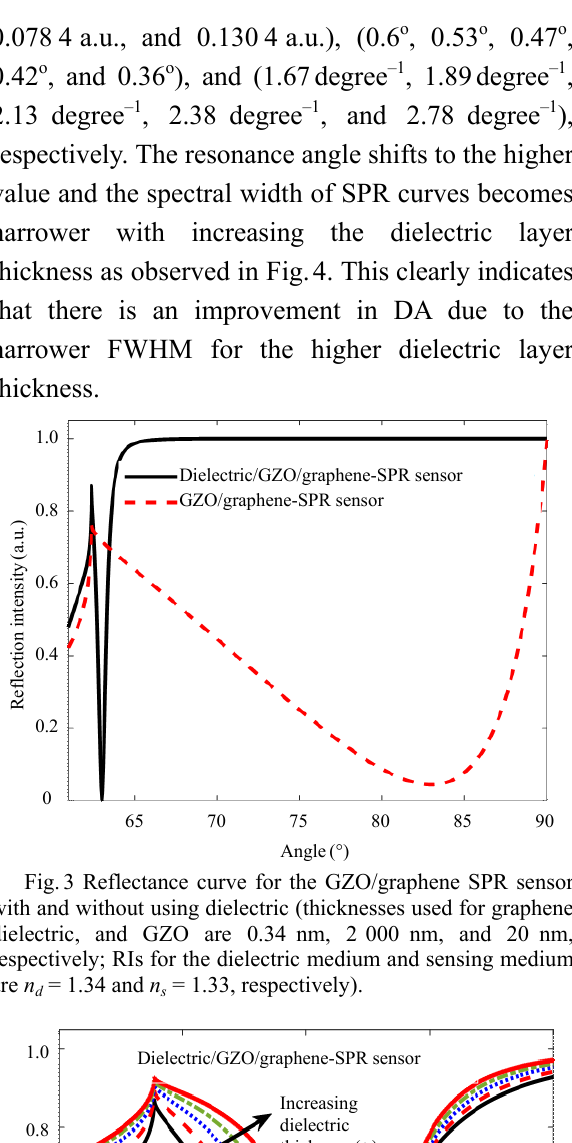
Fig. 5 Reflectance curve for the proposed SPR sensor for dielectric RI variation from 1.34 to 1.38 (thicknesses used for graphene, dielectric, and GZO are 0.34 nm, 2 000 nm, and 20 nm, respectively; RI for the sensing medium is n s =